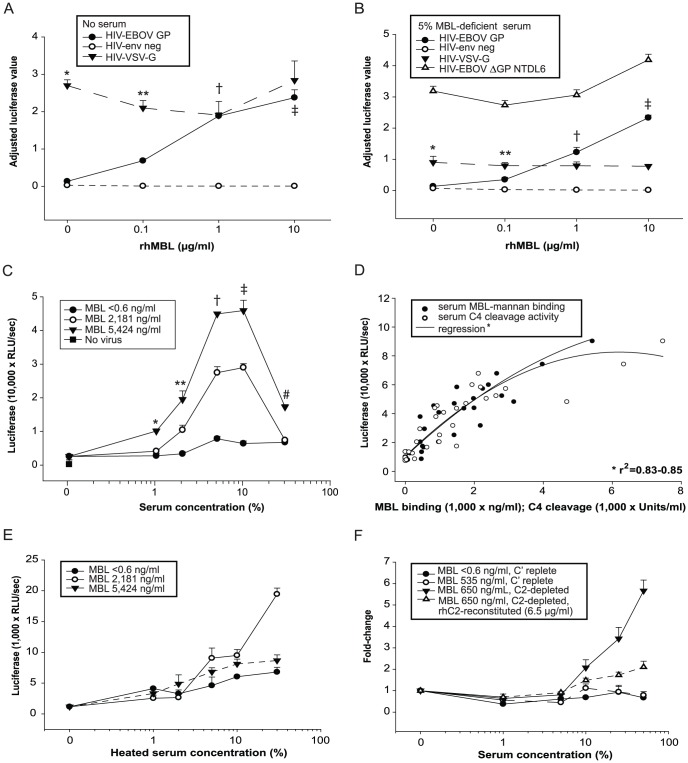
MBL enhances HIV-EBOV GP infection of HEK293F cells in low complement conditions.We used luciferase-encoding HIV-EBOV-GP virion-like particles to infect 5×103 adherent HEK293F cells. Viruses (350 pg p24/100 µl) were preincubated with physiological concentrations of rhMBL (0.1–10 µg/ml) in (A) DMEM or (B) MBL-deficient (<0.6 ng/ml) 5% human serum for 1 hour at 37°C. We analyzed infection rates after 40 hours. Luciferase absorbance values were adjusted for cell viability by normalizing to alamarBlue fluorescence units (resazurin reduction assay) and results are expressed as Adjusted Luciferase Values. Significant differences are shown. * and ** p<0.05 (HIV-VSV-G vs both other virions at 0 and 0.1 µg/ml supplemental rhMBL, respectively), † and ‡ p<0.05 (HIV- envelope negative vs both other virions at 1 and 10 µg/ml supplemental rhMBL, respectively). Also shown in (B) is the reduced capacity of rhMBL to enhance infection by HIV-EBOV-ΔGP NTDL6 (mutated GP lacks 217 amino acids in the heavily glycosylated mucin-rich region) compared with that for HIV-EBOV GP, which contains intact mucin-rich regions (1.3- vs 17.2−fold enhancement, respectively, p<0.001). Experiments were performed twice in quadruplicate. (C) We preincubated HIV-EBOV GP with serial dilutions of serum from three individuals with undetectable (<0.6 ng/ml; LYPB/LYPB), intermediate (2,181 ng/ml; LYPA/HYPD) or high (5,424 ng/ml; HYPA/LYQA) MBL concentrations. Shown are luciferase values. * p<0.05 (high level MBL vs low or intermediate level MBL at 1% serum dilution), **, † and ‡ p<0.05 (all pairwise comparisons at 2%, 5% and 10% serum dilutions, respectively), # p<0.05 (all pairwise comparisons at 30% serum dilution). Experiments were performed twice in quadruplicate. (D) We preincubated HIV-EBOV-GP virion-like particles with 5% serum from 35 ethnically diverse individuals. Shown are associations between level of infection and native MBL activity (mannan-binding or C4 cleavage) for each individual (r2 = 0.83, serum C4 cleavage activity; r2 = 0.85, serum MBL-mannan binding). Experiments were performed in quadruplicate. (E) We preincubated HIV-EBOV-GP virion-like particles with 5% heat-inactivated serum (56°C for 30 minutes) from three individuals with varying MBL levels before infection of cells. (F) We preincubated HIV-EBOV GP virion-like particles with media or sera (diluted to 1–50%) that were complement component 2 (C2)-replete or depleted, and that lacked or contained approximately equivalent MBL concentrations (535–650 ng/ml). In addition, C2 depleted serum was reconstituted with recombinant human C2 (6.5 µg/ml) for comparison. Experiments were performed twice in quadruplicate.